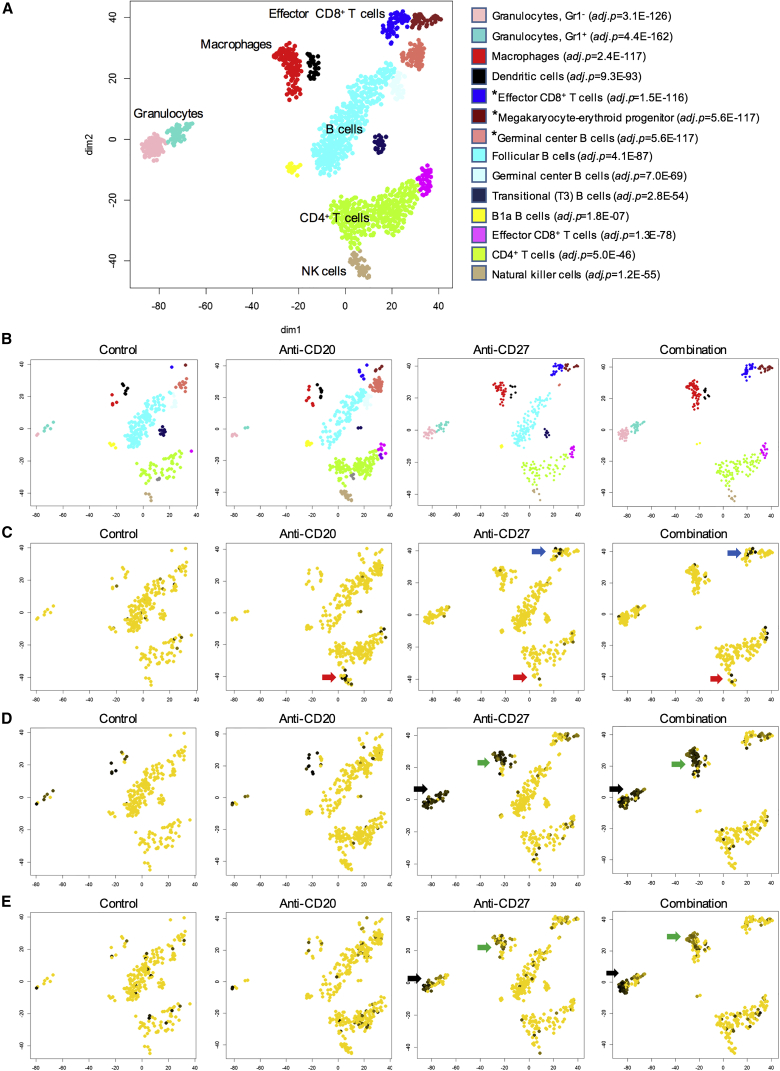
Global Gene Expression Profiling of Anti-CD20 and/or Anti-CD27 Treated BCL1-Bearing Mice(A–E) Single cell RNA sequencing was performed on spleens harvested on day 13 from BCL1-bearing mice treated as described in Figure 4. t-Distributed stochastic neighbor embedding (t-SNE) plots are shown, with each point representing a cell. (A) t-SNE plot showing the individual immune effector subsets, assigned according to their top match with the coexpression atlas of the Immunological Genome Project. Each population is denoted by a different color and those marked with an asterisk (∗) are proliferating. (B) Data from (A) are subdivided into the different treatment conditions to demonstrate changes in the various subsets. (C) Cells in the various condition groups expressing Ccl3 (effector CD8+ T cells and NK cells) are indicated by the blue and red arrows, respectively. The yellow cells lack expression of Ccl3. (D) Upregulation of Ifitm3 on granulocytes and macrophages is indicated by the black and green arrows, respectively. (E) Upregulation of Isg15 on granulocytes and macrophages is indicated by the black and green arrows, respectively. See also Figure S5.